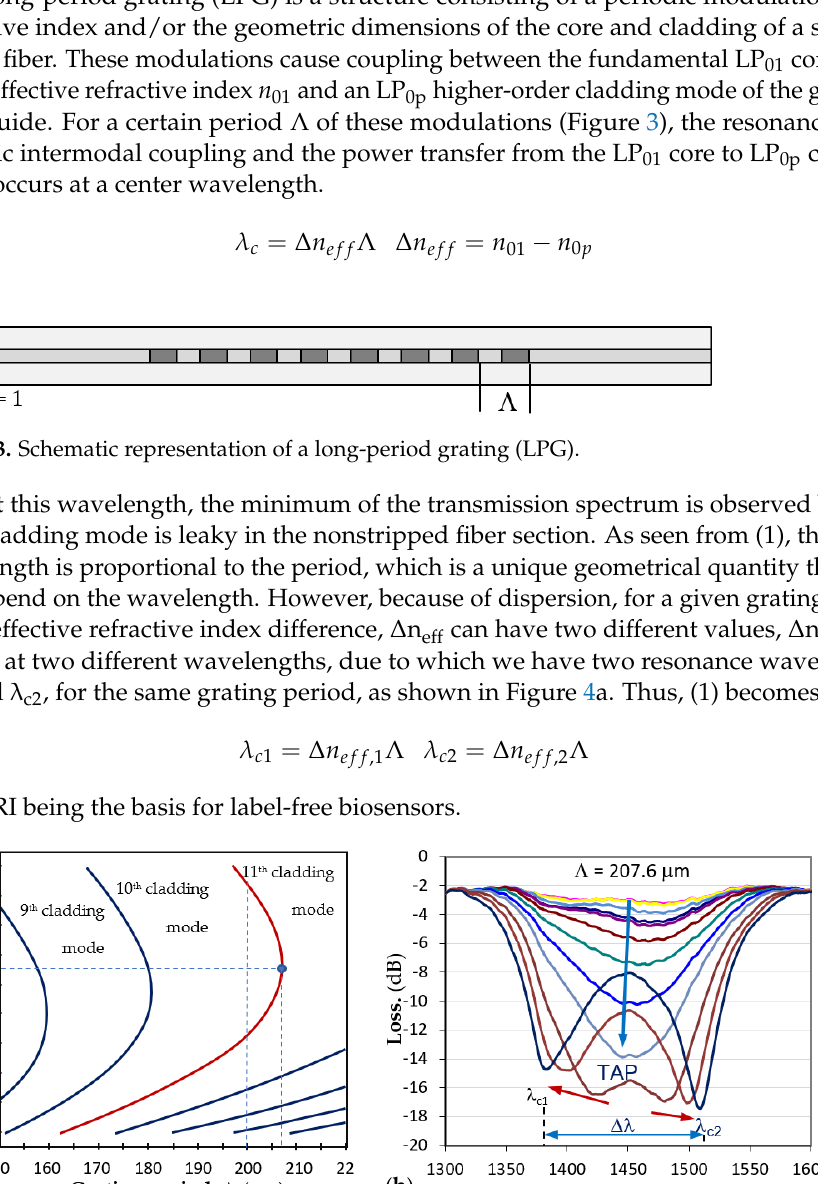
Figure 2. Optical set-up: 1 — tungsten lamp, 2 — collimator, 3 — polarizer, 4 — goniometer, 5 — biochip, 6,7 — objectives, and 8 — spectrometer .